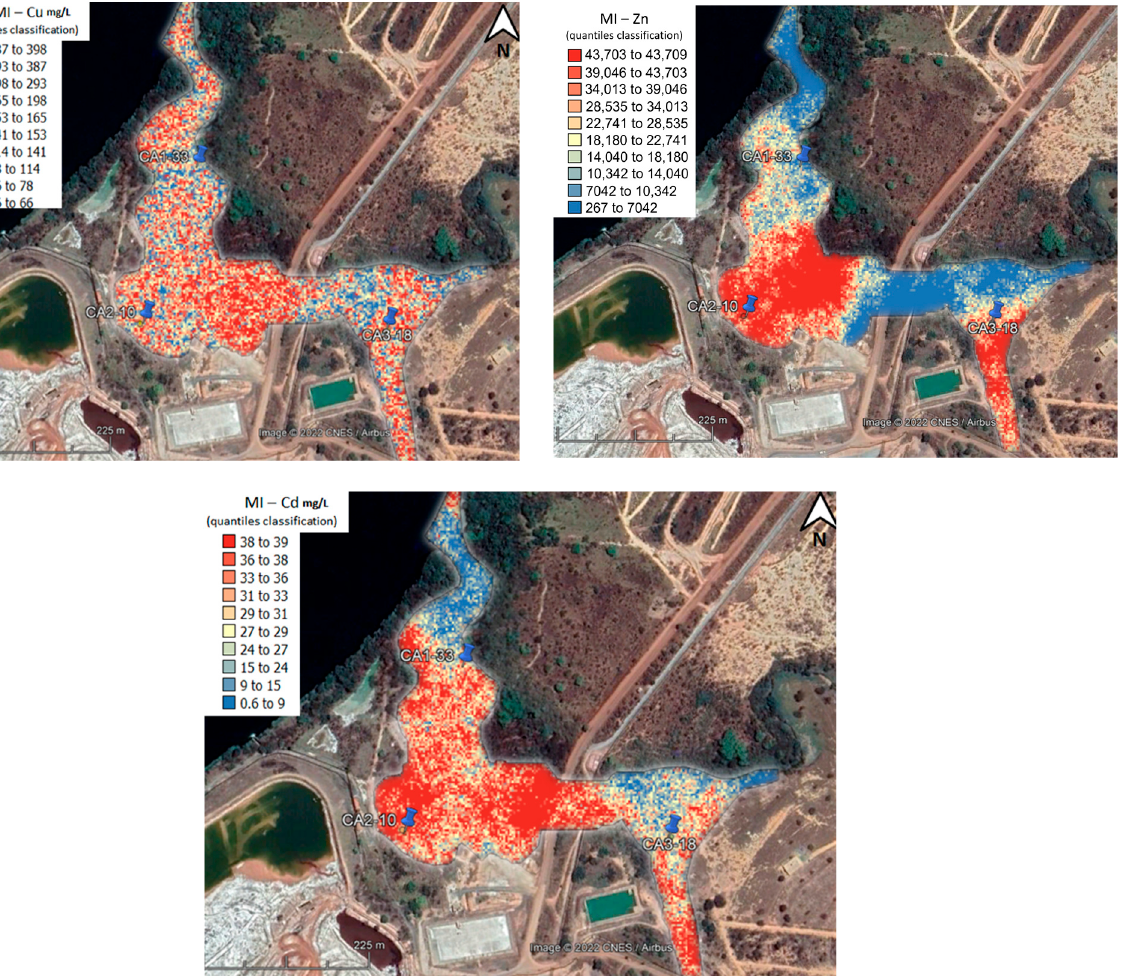
Figure 9. Sequential Gaussian Simulated mean images (MI) for As, Pb, Cu, Zn, and Cd. The test validation samples CA1-33, CA2-10, and CA3-18 were projected overlaying the corresponding simulated map. It is possible to acknowledge that the content level on the target validation points decreased considerably, therefore validating the zero-valent iron nanoparticles (nZVI) technology as a proxy for novel remediation approaches.